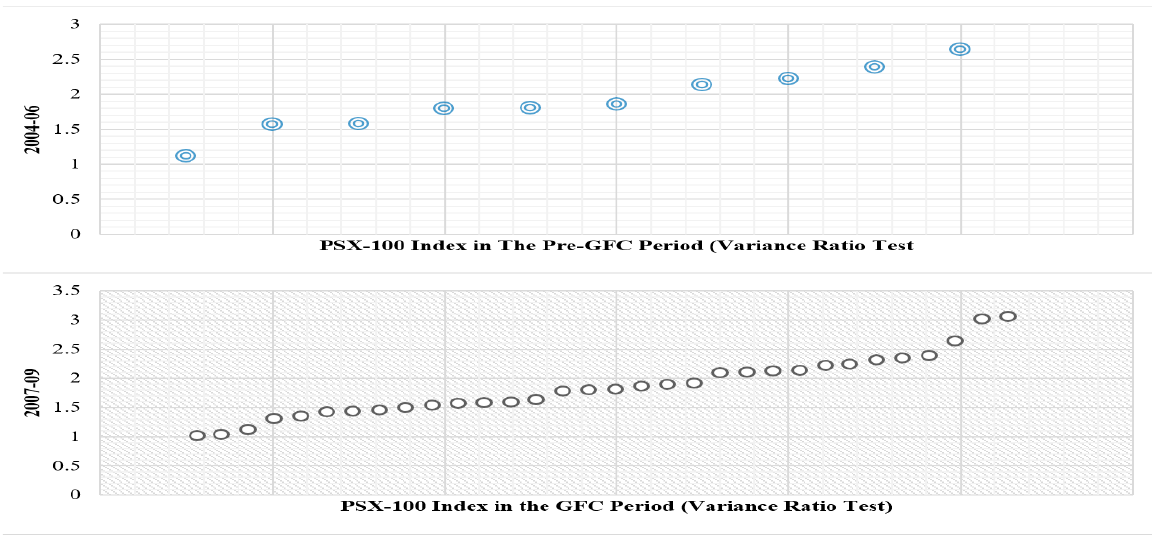
Figure 3. Informational Efficiency of PSX-100 Index in Pre-GFC (2004–2006) and GFC period (2007– 2009).